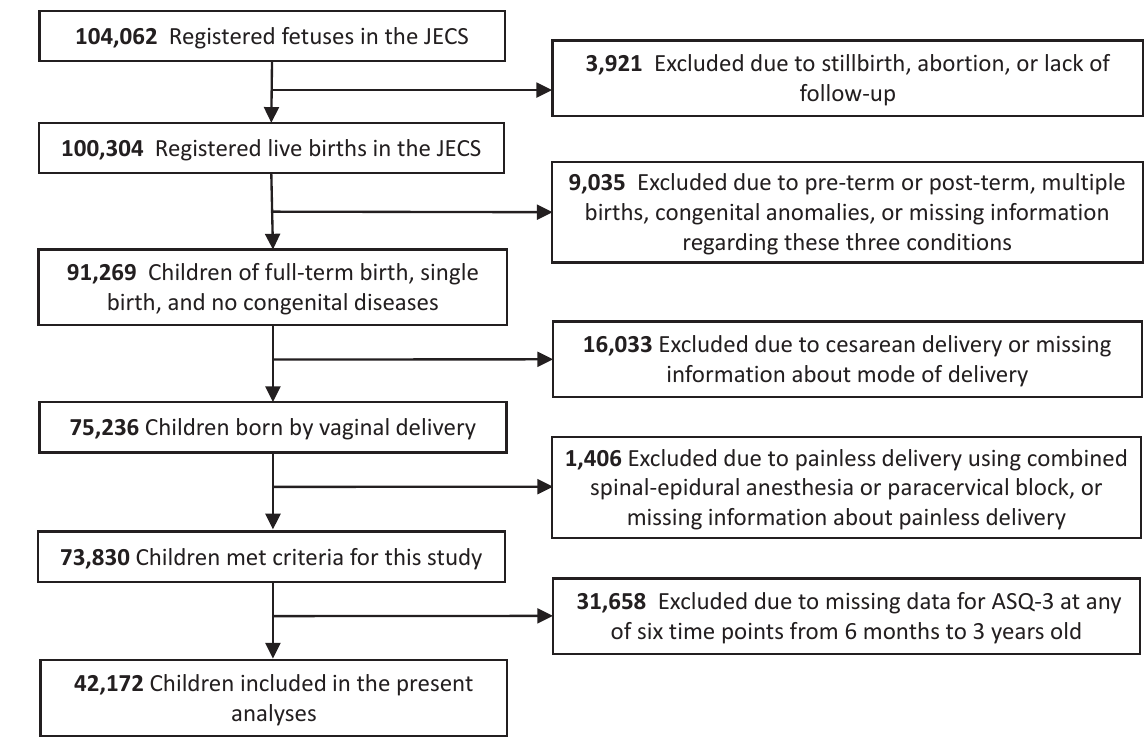
Fig. 1 Flowchart showing the process used to select study